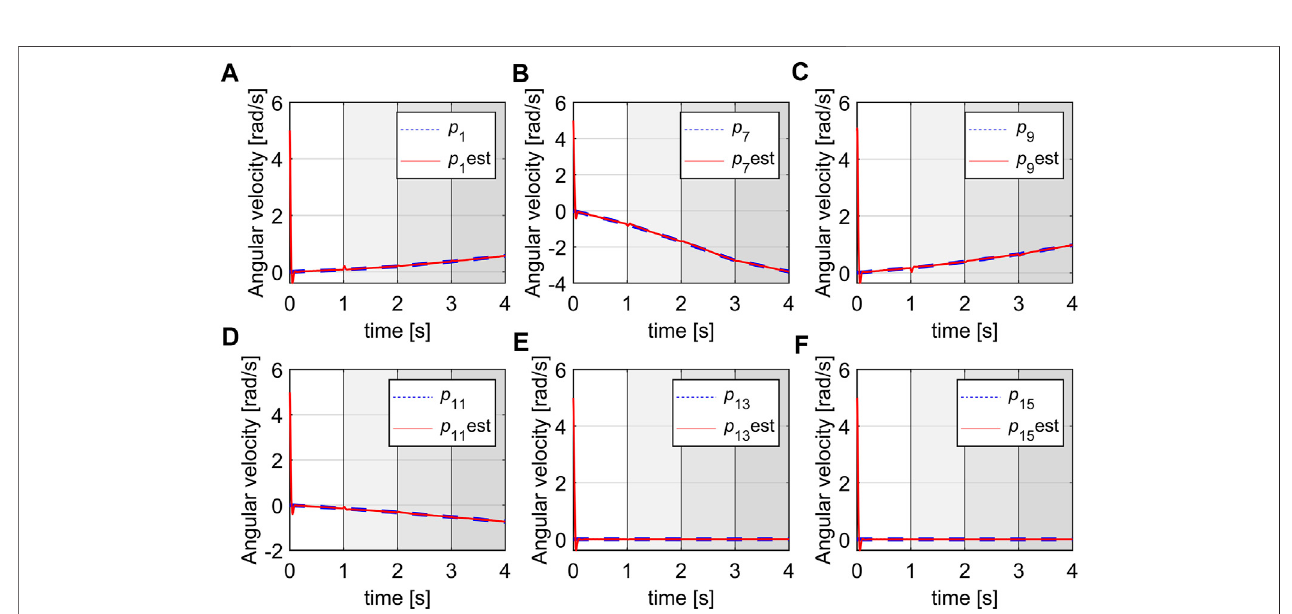
Simulation 1: The simulation occurred over 4 s and is shown in Figure 10 . From the initial time, after each second, the system switched to a new subsystem which is illustrated by a different shading from the light to the darker gray with the darker segments corresponding to a higher pressure. There will be, in total, 15 generalized coordinates to track but due to space considerations, only the estimates of a few representative variables are shown. We can see that from their initial values